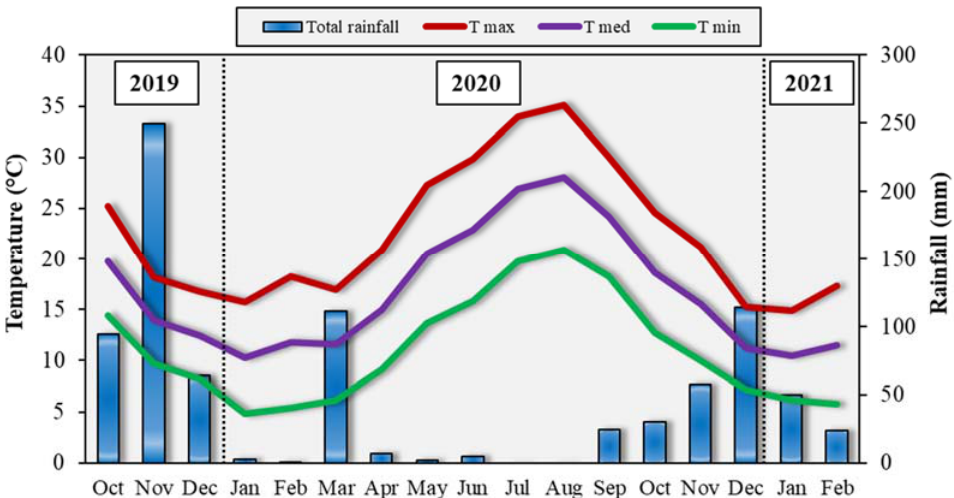
Figure 2. Total rainfall and average monthly maxima and minima air temperatures in the experimental field from October 2019 to February 2021.